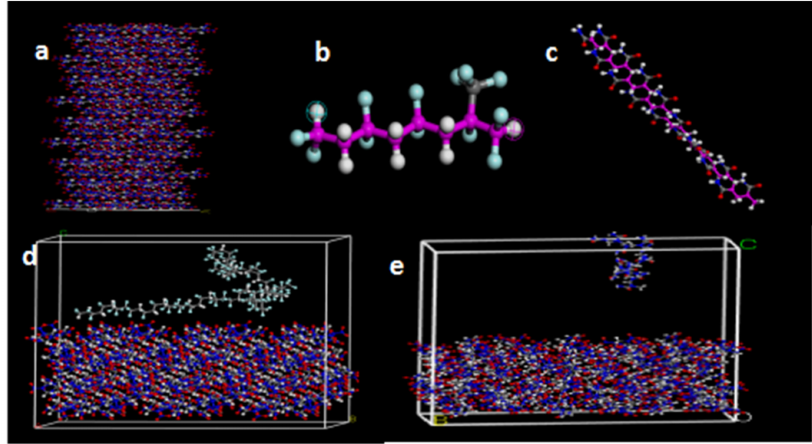
Figure 1. Structural model of di ff erent samples: ( a ) cross section of cyclotrimethylene trinitramine (RDX) unit cell; ( b ) F 2602 ; ( c ) urea-formaldehyde resin binder (UF); ( d ) RDX / F 2602 ; ( e ) RDX /